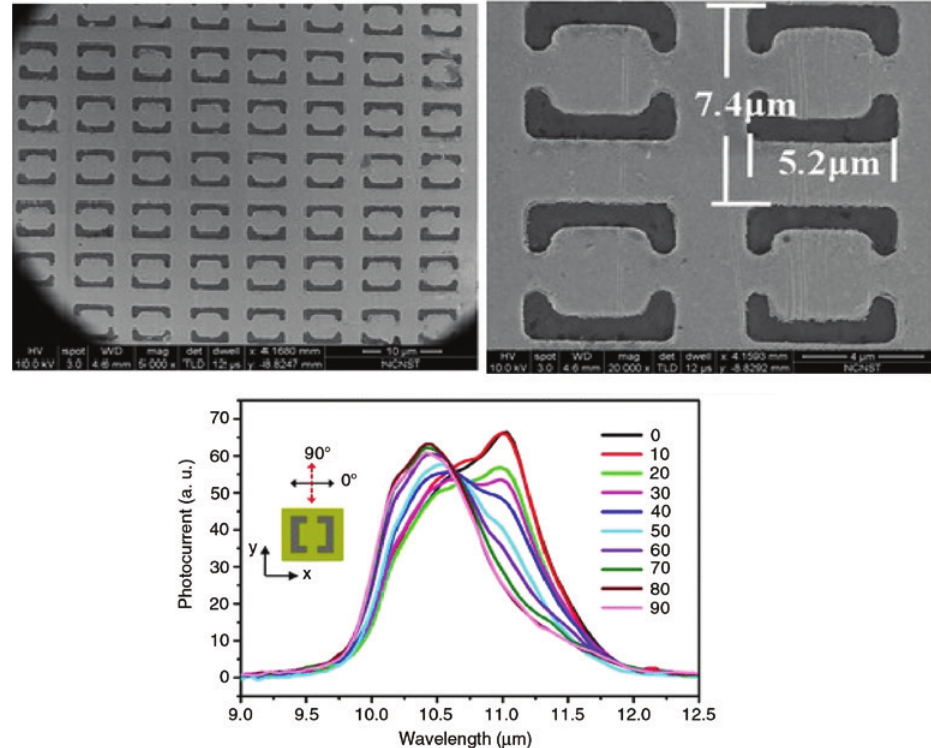
Figure 17: Scanning electron microscopy images of the integrated IRPD with a metamaterial structure. The photocurrent spectra at different polarization angles are presented [216].